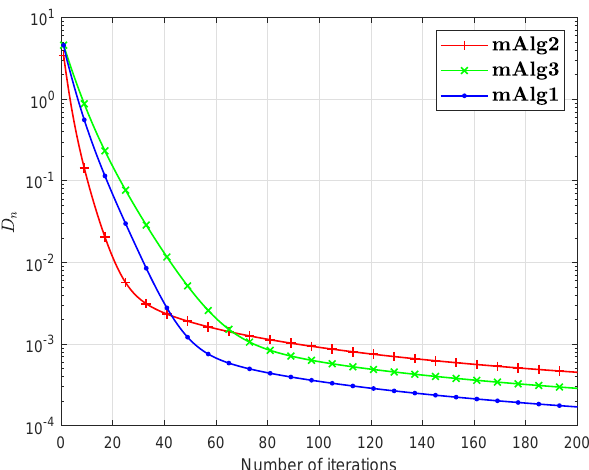
Figure 4. Algorithm 1 compared to Algorithm (60) and Algorithm 3.2 in [34] for R 50 .